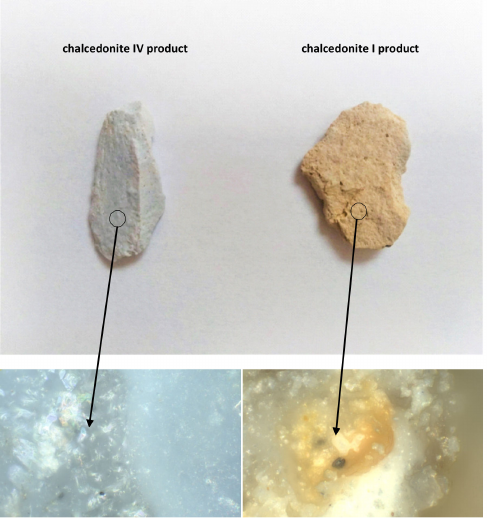
Figure 4. Chalcedonite particles—general view and photographs of microregions taken using a confocal optical microscope Olympus